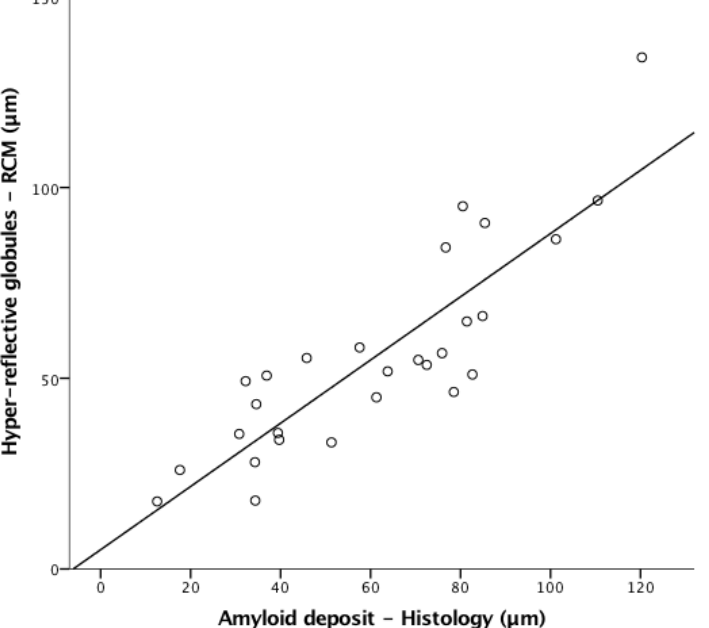
Figure 4. Scatterplot showing the correlation for amyloid deposits seen on reflectance confocal microscopy RCM and histology. Linear correlation between hyper-reflective globules seen on RCM examination and amyloid deposits on CK34βE12 -stained tissue sections. The correlation was strong, resulting in a Pearson correlation of r = 0.862 ( p < 0.001).